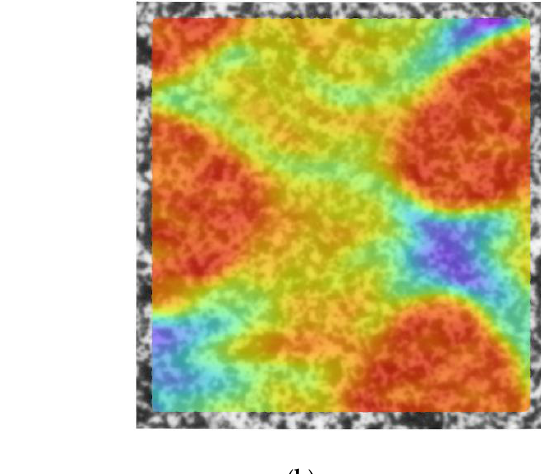
Figure 7. Model of the fragment of the microstructure that is expected behind the speckle pattern: ( a ) FE model, ( b ) overview on the result of the DIC analysis in Istra 4D software (ε yy distribution).